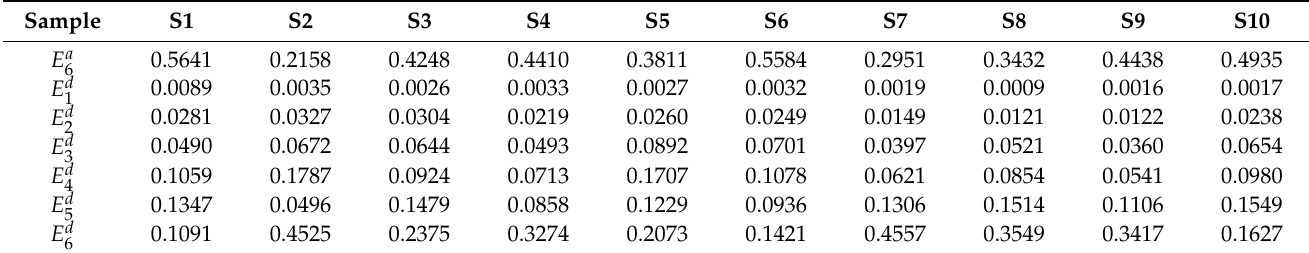
Table 2. Energy eigenvector of ship engine acoustic signal.